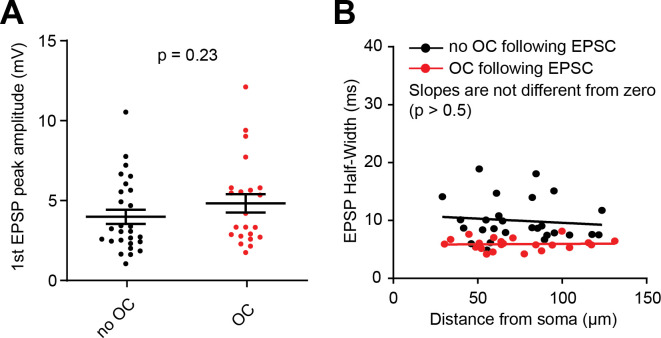
Control experiments for spikelet effect on excitatory postsynaptic potentials (EPSPs).(A) The amplitude of the first EPSP is not significantly different between those extracellular stimulation sites where an outward current could be detected (OC, red group, n = 22 sites) and those lacking a detectable outward current after the initial excitatory postsynaptic current (EPSC) (no OC, black group, n = 27 sites - Mann-Whitney test, p=0.23). (B) Relationship between EPSP half-width and distance between stimulation electrode tip location and patched somata (same color code as in A). In both groups, no significant relationship is observed (No OC: p=0.61, OC: p=0.87). See also Figure 7—figure supplement 1—source data 1.